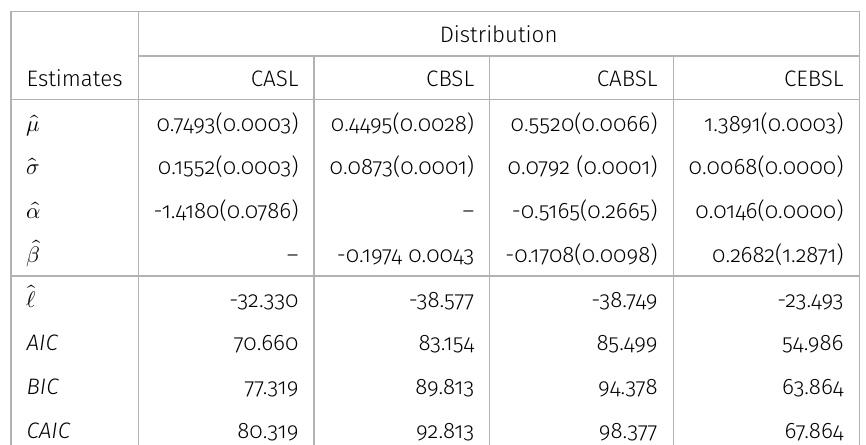
Table III. Parameter estimates (S.E) of the fitted models to the Stellar abundances data set.